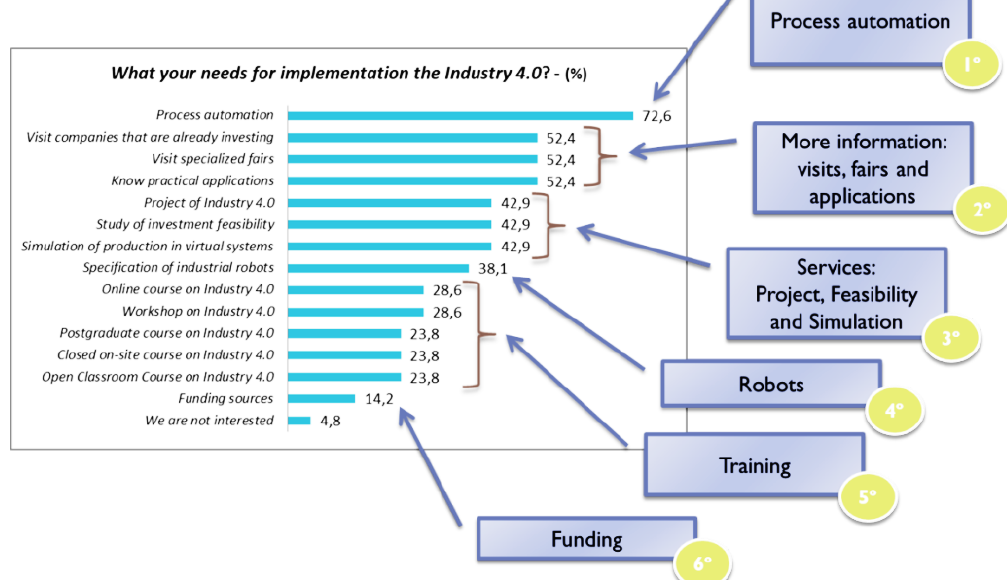
Figure 8. What needs to be done to support the transition of Brazilian companies to Industry